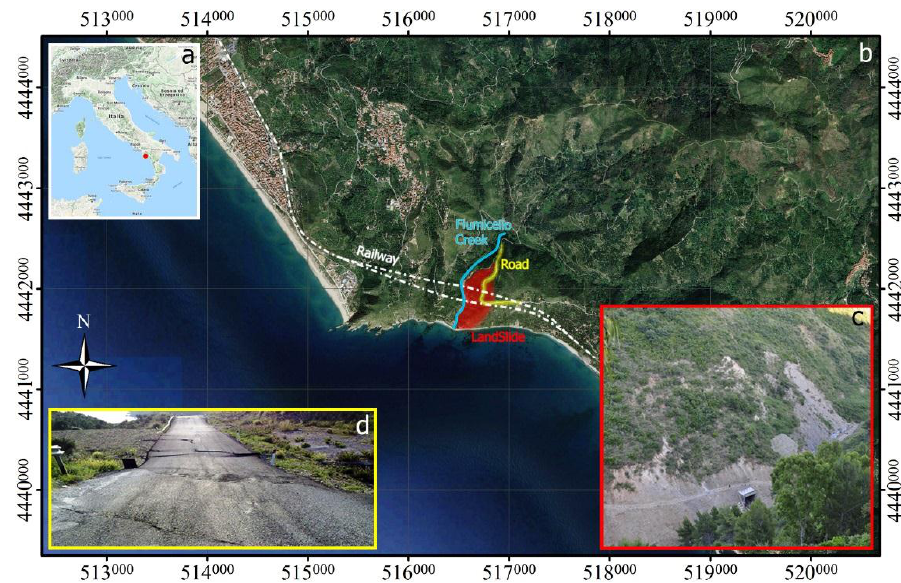
Figure 1. Test area. ( a ) Map of Italy. The red dot points out the test area; ( b ) Location map; ( c ) A picture of the landslide toe; ( d ) A picture of a stretch of ‘Palinuro’ State Road 447, showing deformations and ruptures.